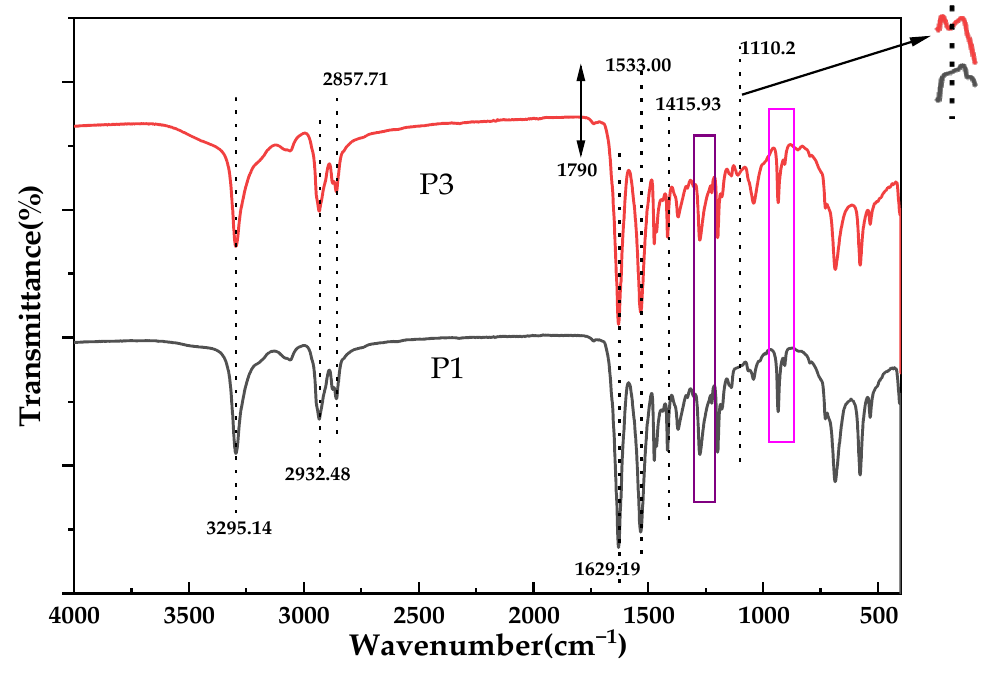
Figure 2. FTIR spectra of different kinds of PA66 membranes.